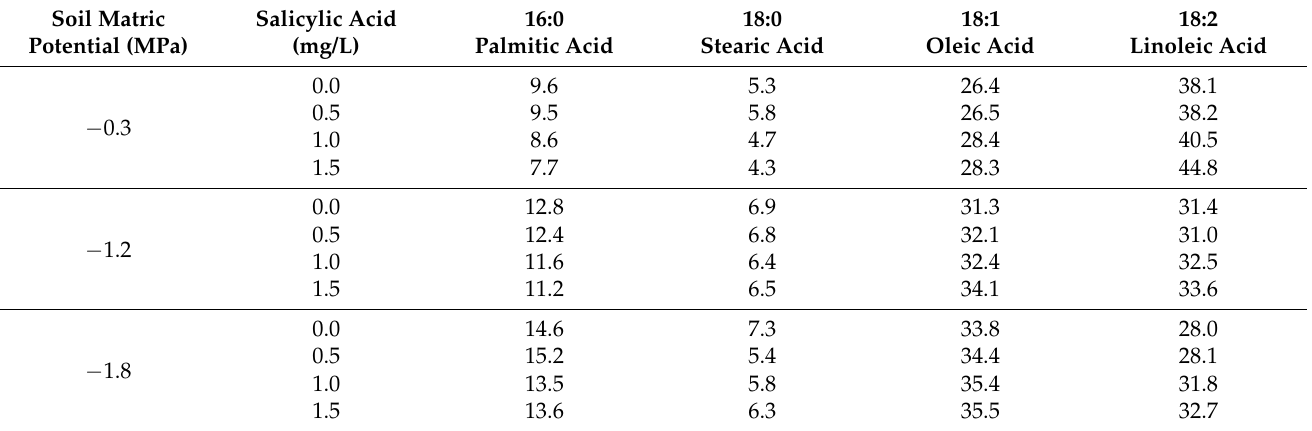
Table 5. Interaction of irrigation regime at three soil matric potential levels and salicylic acid on some fatty acid composition (The soil matric potential (MPa) value was measured just before